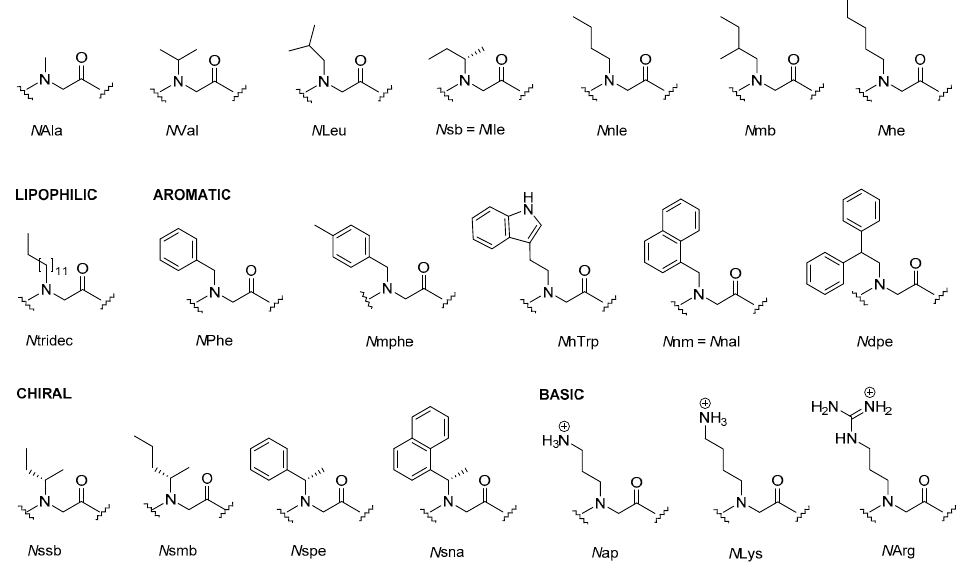
Figure 6. Structure of commonly used peptoid building blocks. N Ala: N -methylglycine; N